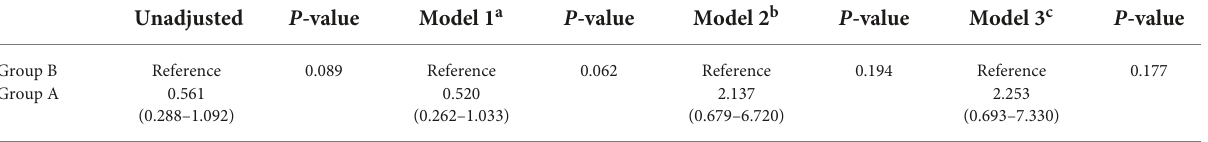
TABLE 5 Cox regression to compare the prognosis between the arteriolar lesion group and proliferative lesion group.